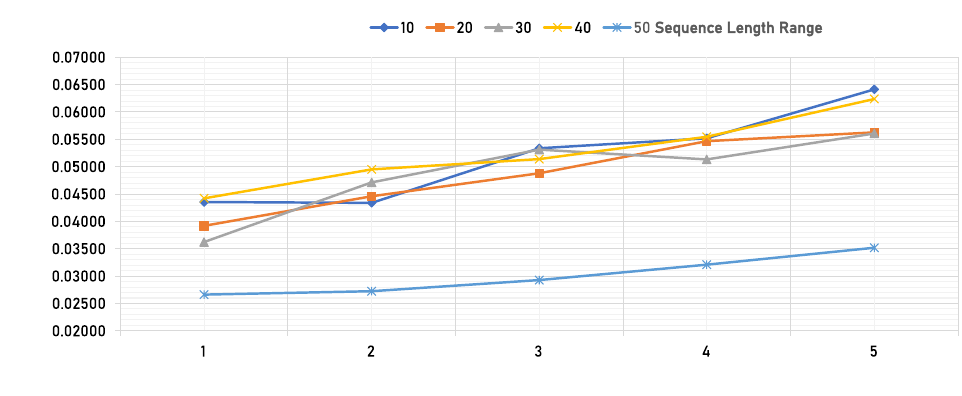
Fig. 11 A graphical summari- zation of the reported results using GRU and “Ethereum USD (ETH-USD)” dataset